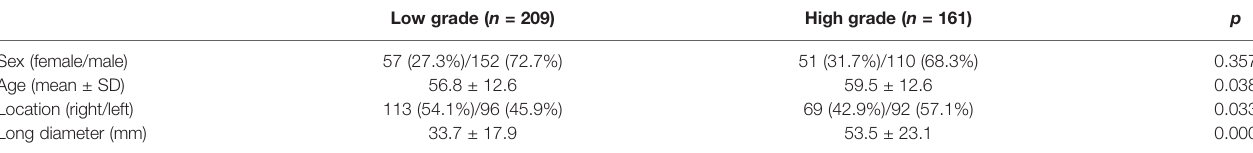
TABLE 2 | General clinical